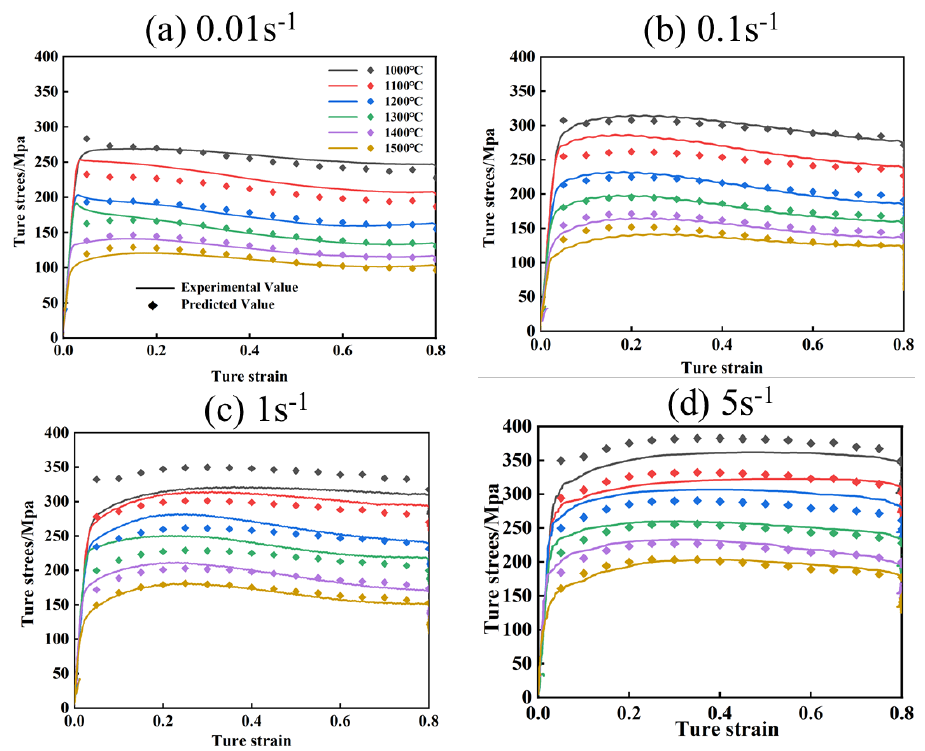
Figure 12. Comparison of experimental and calculated values of flow stress of Mo − 1.5wt% ZrO 2 : ( a )